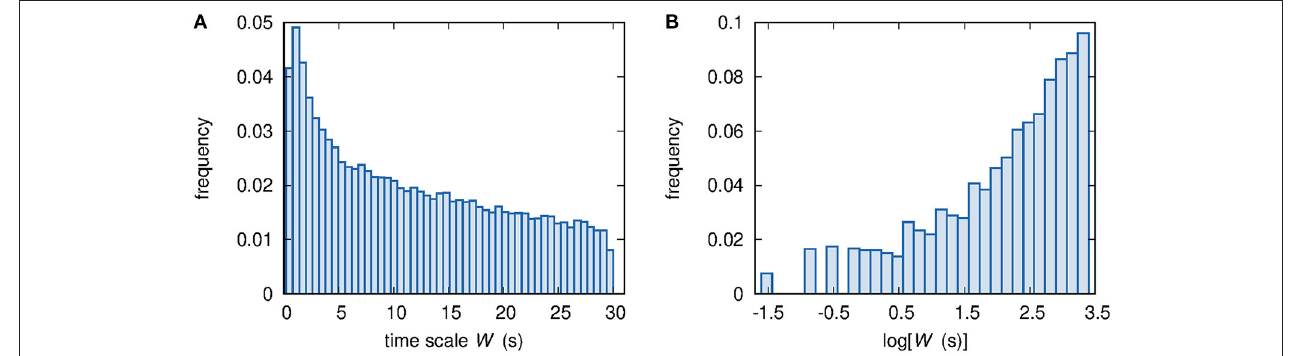
FIGURE 6 | (A) Joint sample probability distribution f ( d , W ). The surface plot and the corresponding color map projection on the d , W plane are obtained by partitioning both the d and the W range in 25 bins each. Integrating f ( d , W ) along W yields the sample marginal probability distribution of d , which is shown by means of a blue line (B) . Similarly, the red line (C) shows the marginal sample probability distribution of W . (D) Sample conditional probability distribution f ( W | d ) of W given d , evaluated as f ( d , W ) / g d ( d ). (E) Color map representation of the sample conditional probability distribution f ( W | d ); the d and the W range are partitioned in 50 bins each. White dots show the average value W of W given d . White dashed lines bound the 68% confidence region for W , namely the region within 1 σ from the average W .